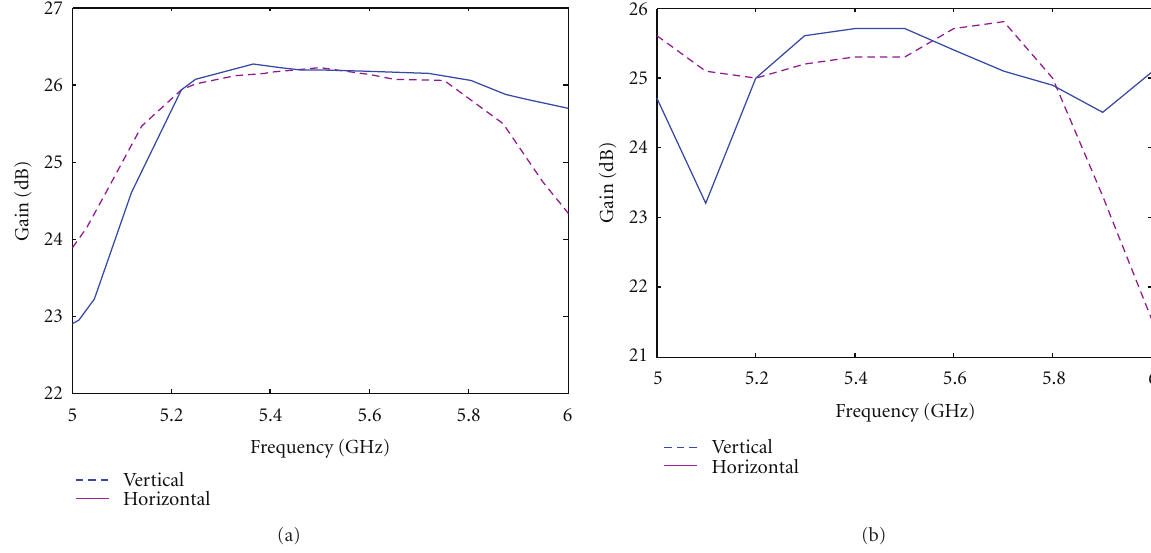
Figure 5: Gain versus frequency of 8 × 8 array antenna: (a) simulated and (b) measured.